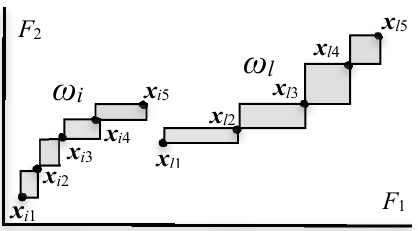
Figure 2. Representations of objects by bin-rectangles in the quartile case.